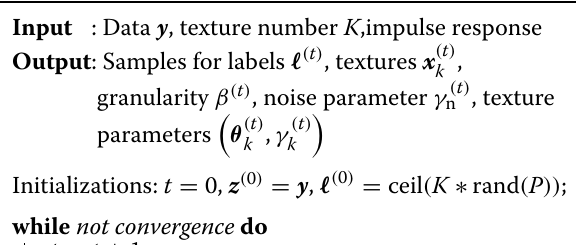
Algorithm 1: Deconvolution-Segmentation of Textures